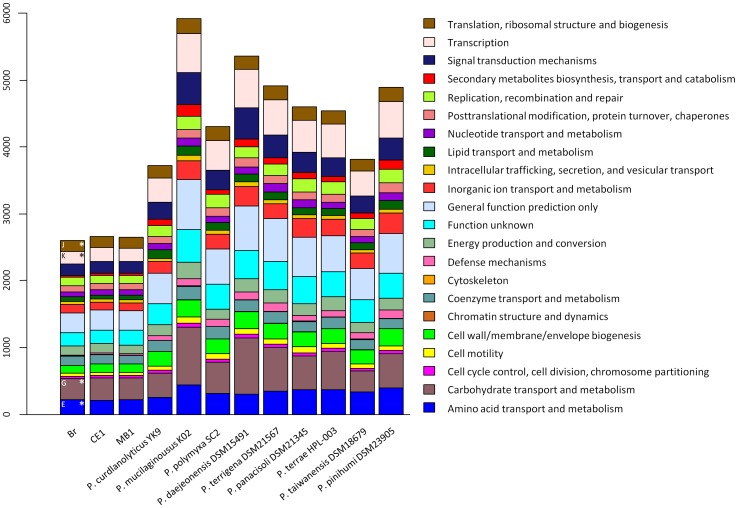
Comparison of gene content in temperate Paenibacillus spp. and P. darwinianus strains by COG categories.